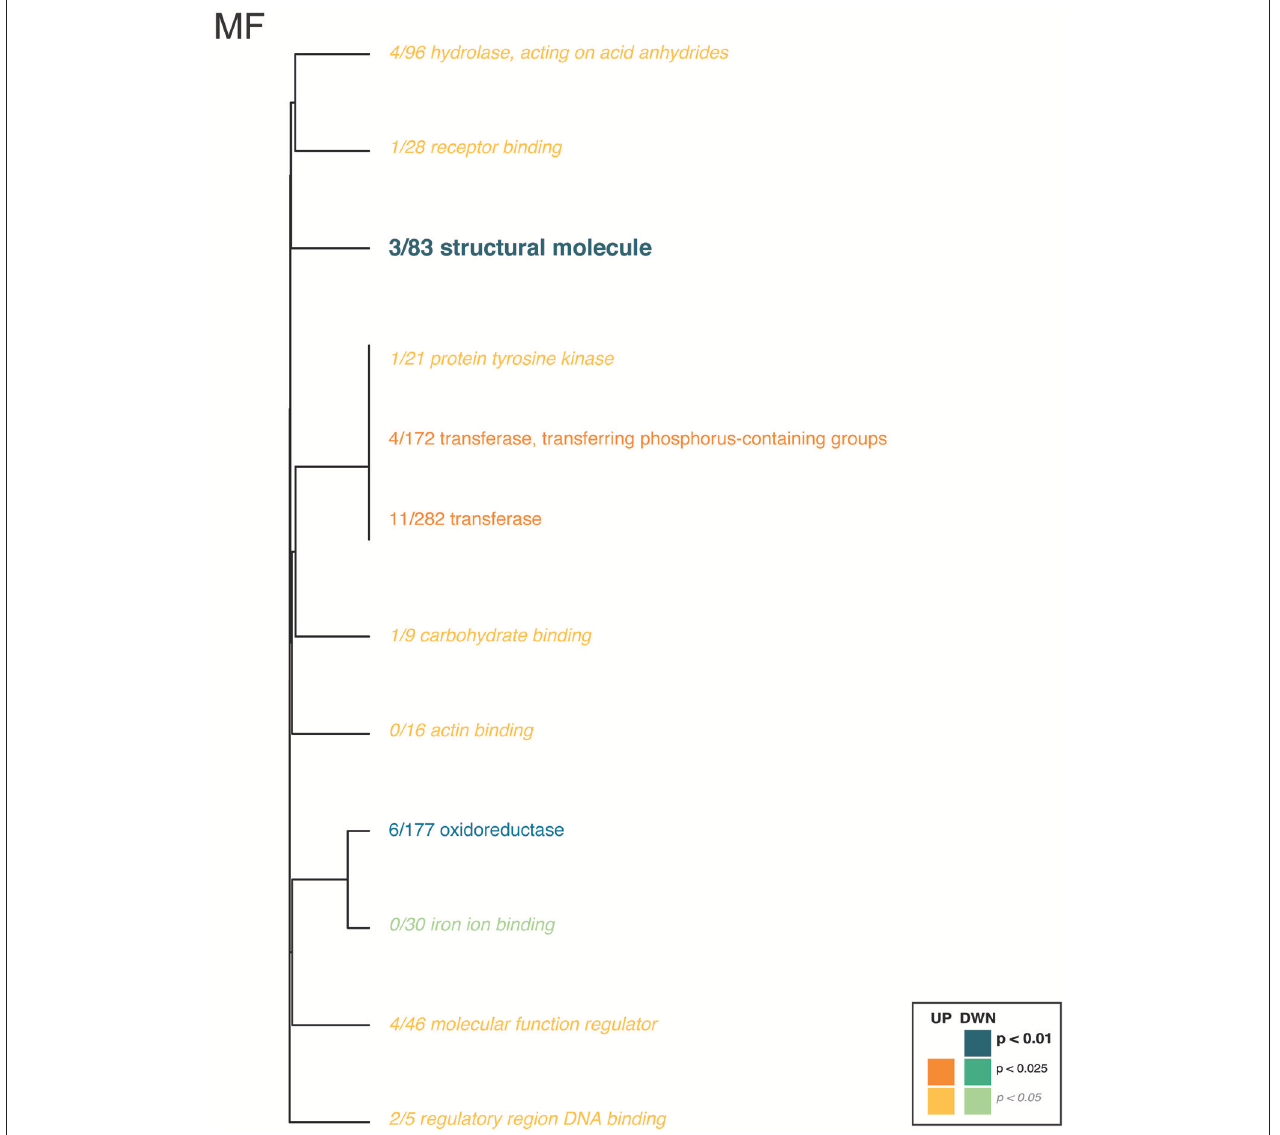
FIGURE 3 | Gene ontology categories enriched by genes of Pocillopora damicornis larvae that are up-regulated (shades of orange) or down-regulated (shades of turquoise) in response to conditions of warming and ocean acidification. For coral host tissue, only the molecular function category (MF) contained any ontologies with significant enrichment. The size of the text and darkness of the color indicate the significance of the term as indicated by the inset key. The fraction preceding each GO term indicates the proportion of genes annotated with the term that pass an unadjusted p -value threshold of 0.05. The trees indicate sharing of genes among GO categories (the categories with no branch length between them are subsets of each other).